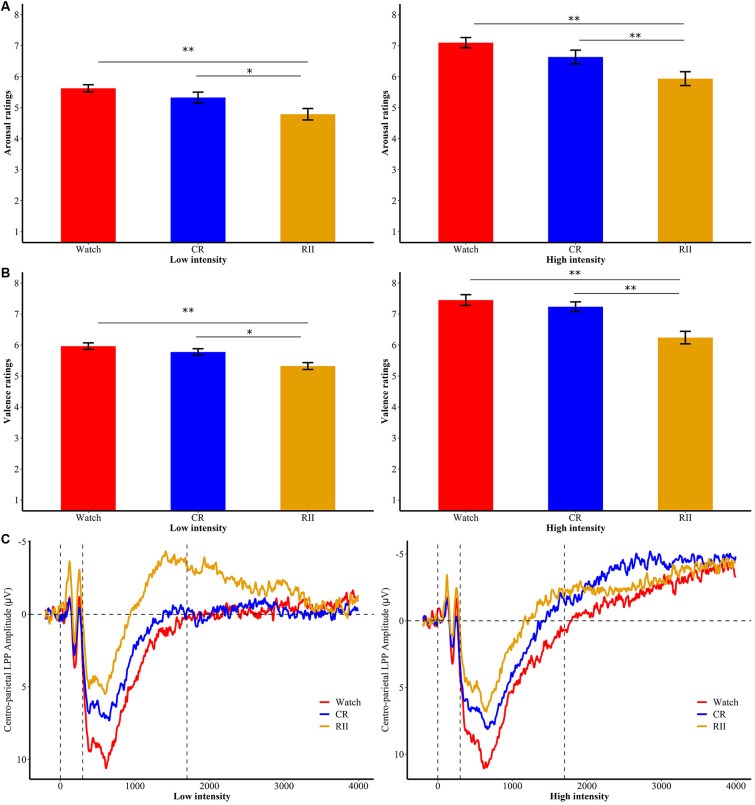
Subjective ratings of (A) emotional arousal and (B) valence for RII, CR, and watch groups in high and low emotional intensities of the re-exposure task. *p < 0.05; **p < 0.001; bars represent standard error. RII, reappraisal by implementation intention; CR, controlled reappraisal. (C) Centro-parietal LPP amplitudes for RII, CR, and watch groups in high and low emotional intensities of the re-exposure task. Waveforms are averaged across CPz and Pz electrodes. The x-axis runs from the beginning of the baseline (−200 ms before picture onset) to the end of the picture presentation (4,000 ms).